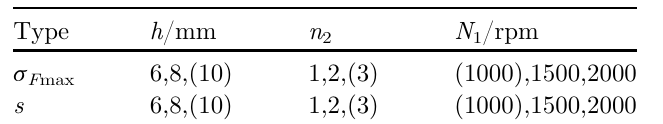
Table 1. Parameter selection.